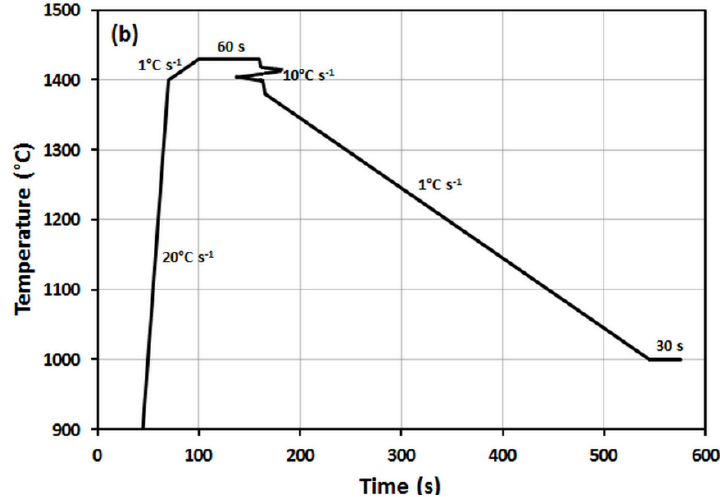
Figure 2. ( a ) Effect of strain rate on ductility. ( b ) Applied thermal cycle.